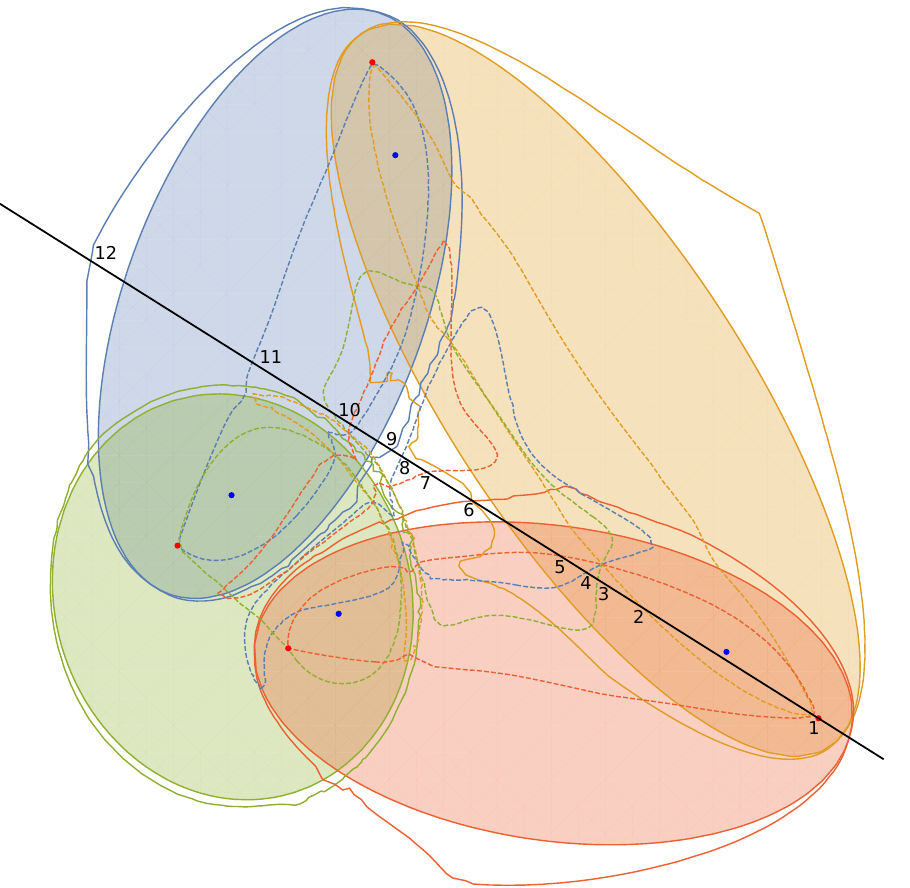
Figure 11. A line segment in integration momentum space: at annotated point 1, the line crosses a focal point. Features 2 to 12 are crossings with the line and the points, where either the real (solid) or the imaginary part (dashed) of the deformed E-surface equations vanishes. See (cid:12)gure 12 and (cid:12)gure 13 for more details on the deformation magnitude and the integrand along this line.